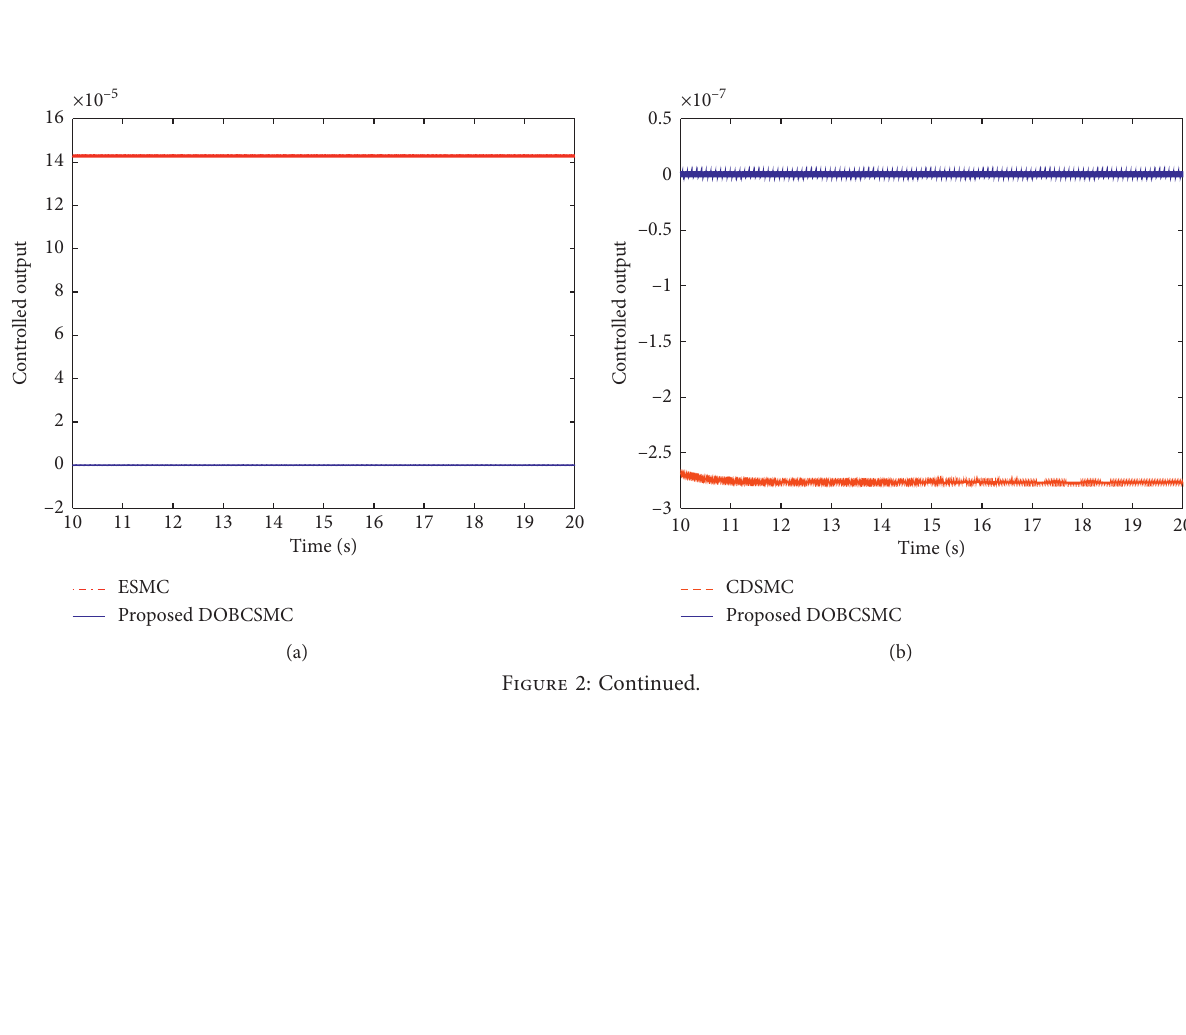
Figure 1: Simulation results of Scenario I.